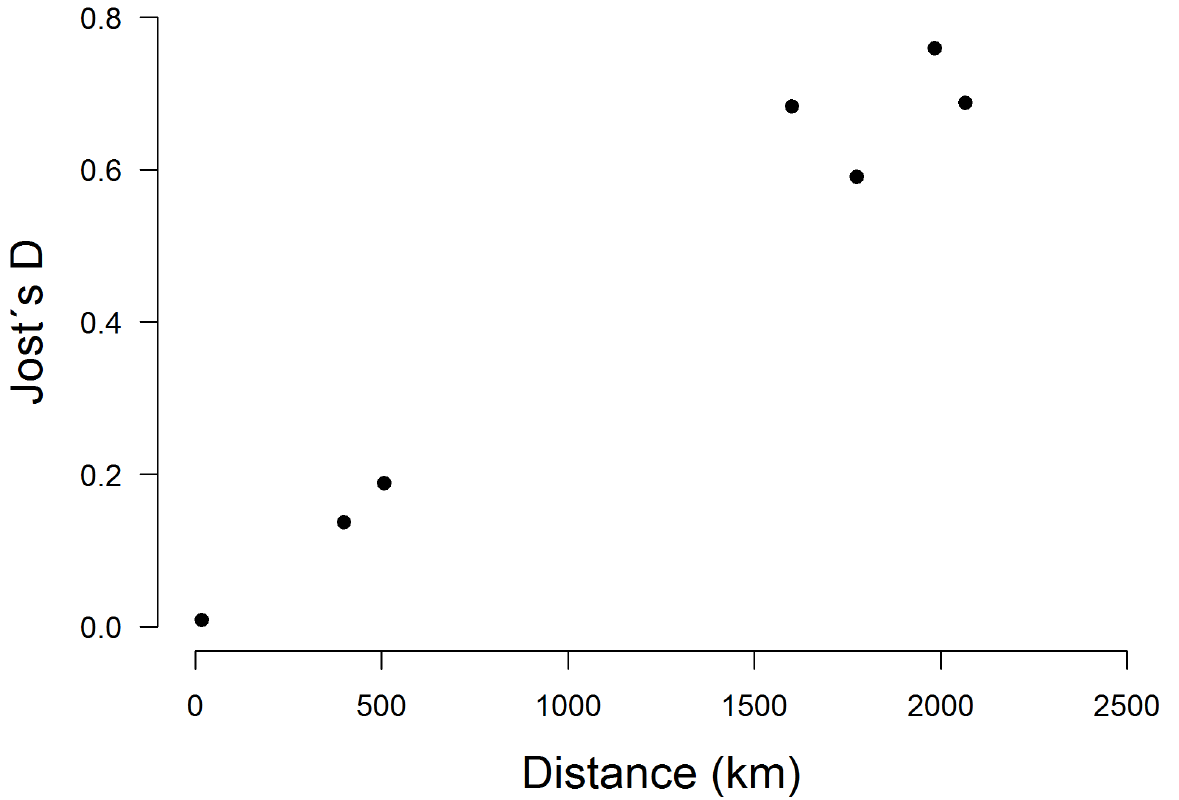
Fig 4. Genetic differentiation among F . insipida sampling sites located in Panama, Costa Rica and Peru. Genetic differentiation given as Jost´s D est increases linearly with spatial distance as expected under IBD or IBB (adjusted R 2 = 0.962, p < 0.001). As there was no population substructure among Panamanian sampling sites, they are represented by one data point at short distance while the other data points are pairwise comparisons among Panama, Costa Rica, Western and Eastern Peru.